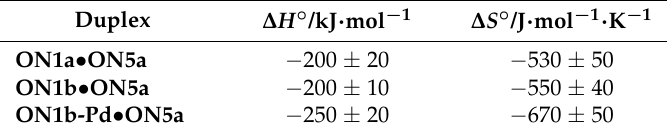
Table 2. Thermodynamic parameters of hybridization for ON1a • ON5a , ON1b • ON5a and ON1b-Pd • ON5a ; pH = 7.4 (20 mM cacodylate buffer); [oligonucleotides] = 3.0 µ M; I (NaClO 4 ) = 0.10 M.